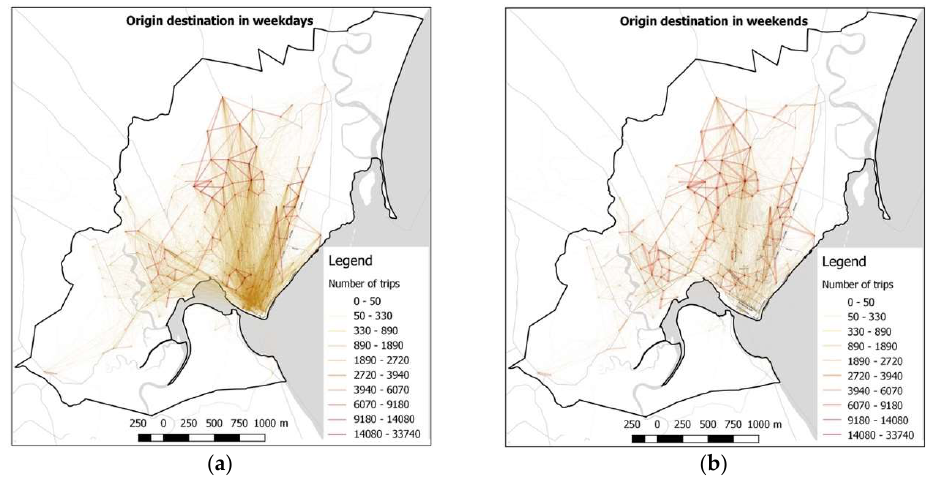
Figure 14. People flow maps in Greater Maputo: ( a ) on weekday, and ( b ) on weekend.